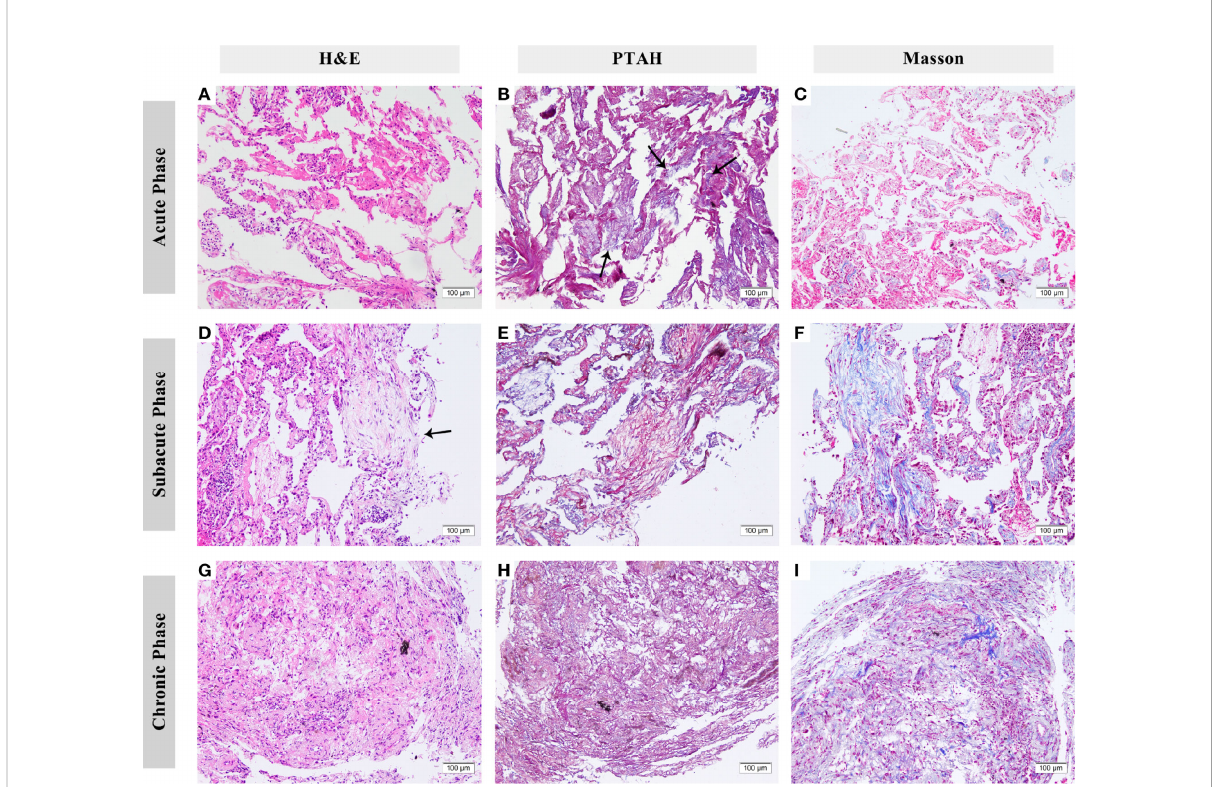
FIGURE 3 Histologic features of checkpoint inhibitor-related pneumonitis (CIP) in different phases. (A – C) Lung biopsy eight days after the onset of CIP. Fibrinous exudation can be seen in the alveolar cavities, especially under phosphotungstic acid hematoxylin (PTAH) staining (arrows). (D – F) Lung biopsy 83 days after onset. Organizing changes are dominant (arrows). Under PTAH and Masson staining, it can be seen that the lesion is in a state of coexistence of fi brinous exudation and fi brosis. (G – I) Lung biopsy 139 days after onset. The fi brosis replaced the normal structure of alveoli with the thickening of blood vessels. H&E, hematoxylin and eosin. PTAH, phosphotungstic acid